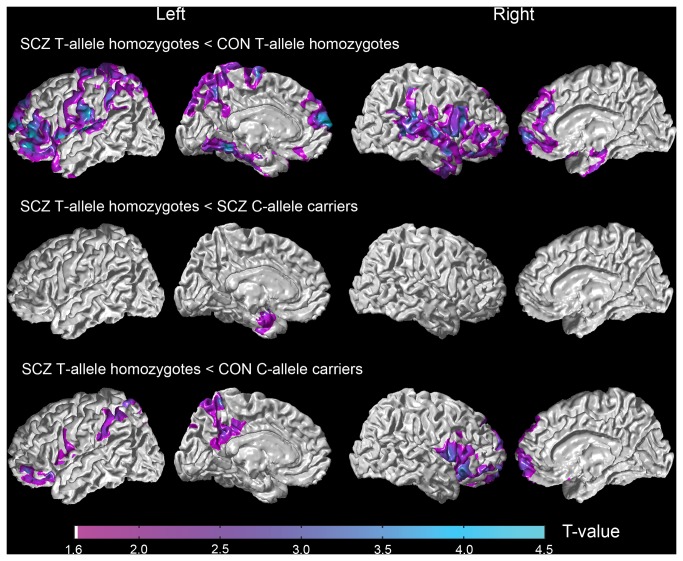
Statistical maps of cortical thickness differences between schizophrenia T-allele homozygotes and: control T-allele homozygotes (top panel); schizophrenia T-allele homozygotes and schizophrenia C-allele carriers (middle panel); schizophrenia T-allele homozygotes and control C-allele carriers (bottom panel).T-values are shown only in the regions with significant group differences after correction for multiple comparisons. Keys: SCZ – Schizophrenia; CON – Control.